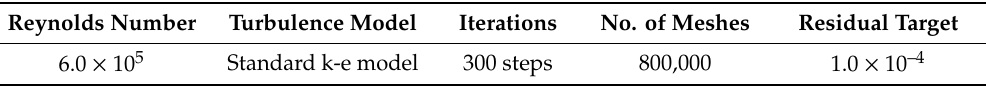
Table 2. The solver parameters.